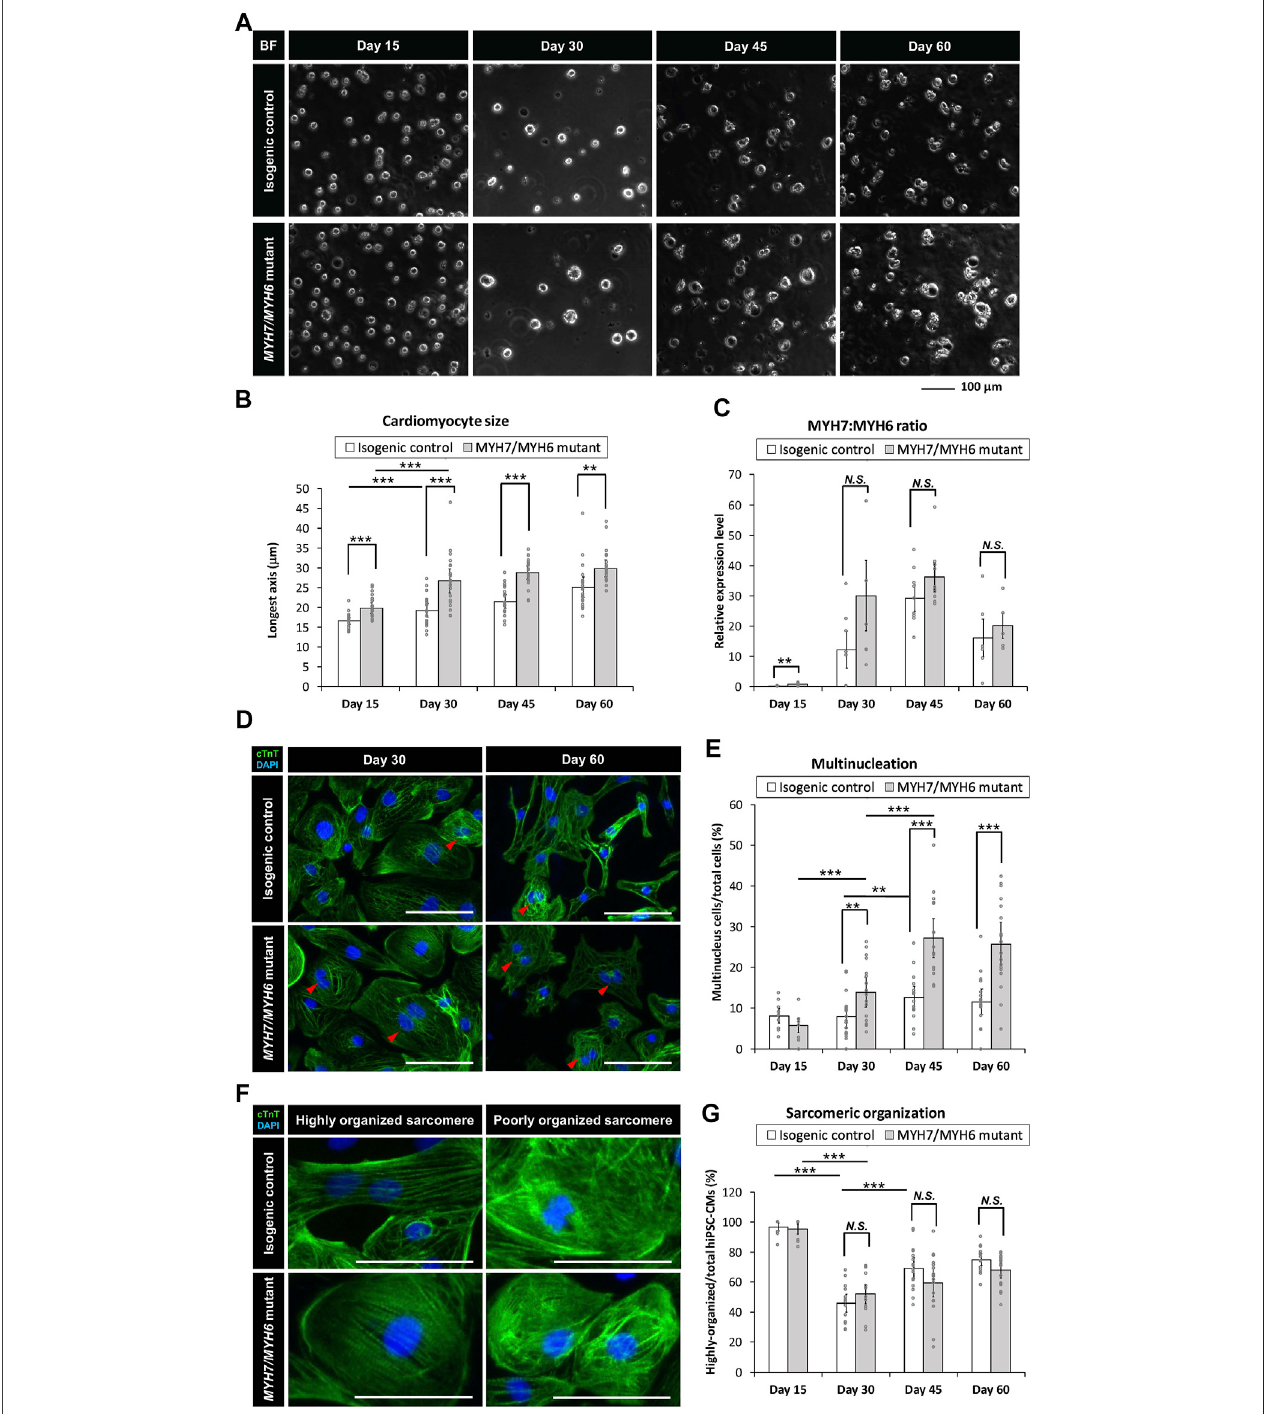
FIGURE 2 | MYH7/MYH6 mutation recapitulates the hypertrophic cardiomyopathy phenotype in the hiPSC-CMs. (A,B) Bright- fi eld images (A) and quanti fi cation (longest axis) (B) ofthere-platedcontrolandmutantcardiomyocytespriortotheirattachment tothesubstratetoanalyzetheirsizeatDay15 – 60ofdifferentiation. Notice thehypertrophyofthemutantcellsfromDay15 – 60.(ScaleBar=100 μ m).Datarepresentsmean±SEM.(** p < 0.01;*** p < 0.005;Student t test; n =24forsixrandomly picked particles with round and intact boundary from four bright fi eld images per condition) (C) MYH7 : MYH6 ratio obtained from qPCR analysis. Data represents mean ± SEM. (** p < 0.01; N.S. : not signi fi cant; Student t test; three wells for each condition and two experimental replicates for Day 15, Day 30, and Day 60, three experimental replicates for Day 45; n = 6 for Day 15, Day 30, and Day 60, respectively, and n = 9 for Day 45 conditions) (D) Representative images of cTnT-